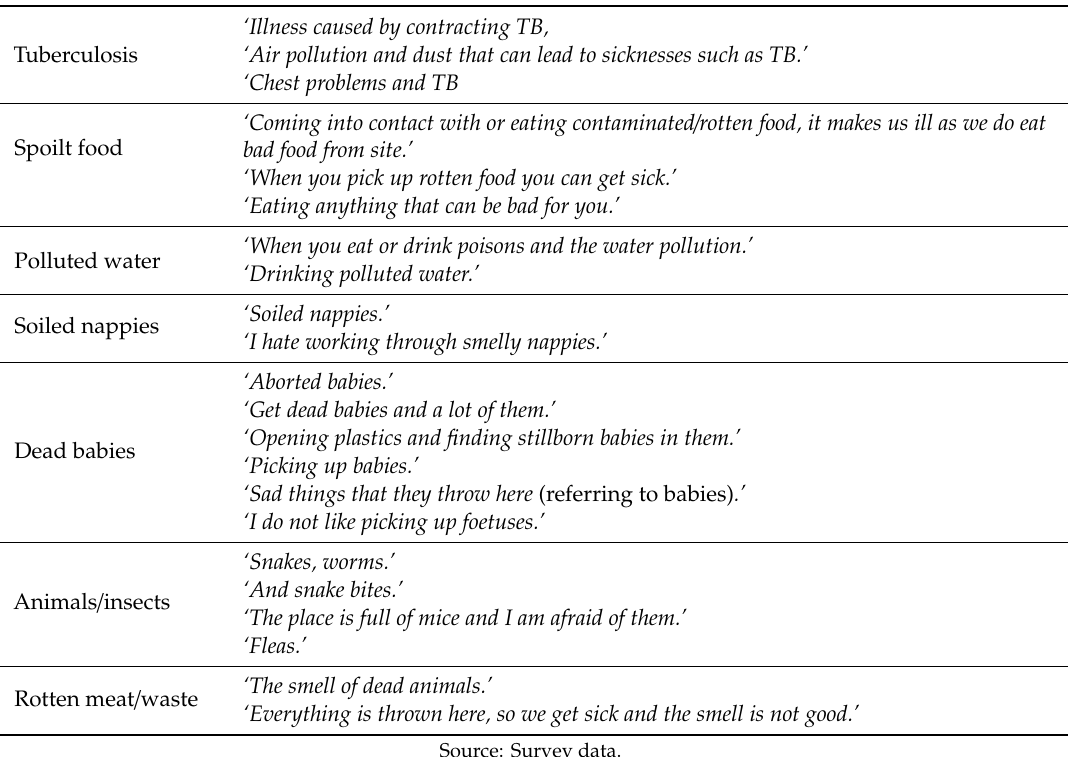
Table 9. Biological risks mentioned by waste